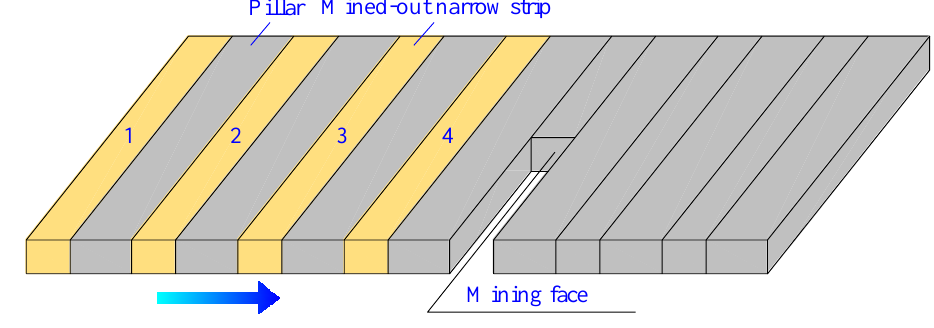
Figure 19. Sketch map of narrow strip mining.